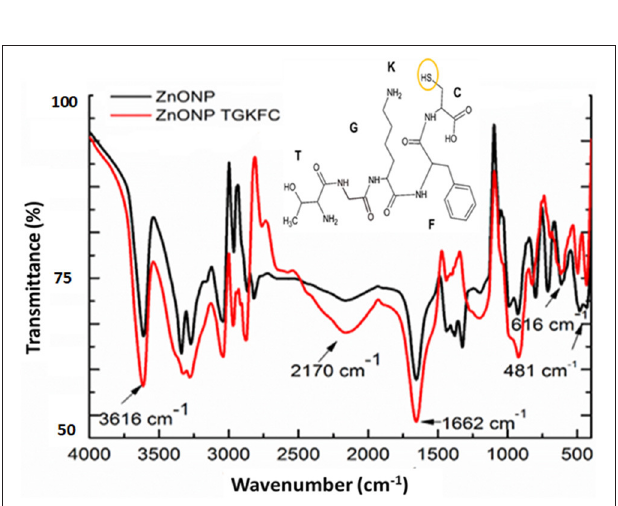
FIGURE 2 | Fourier transform infrared spectra of ZnONPs-TGKFC. Black line ZnONPs alone; Red line the ZnONPs bound to TGKFC. The molecular structure of the peptide was also reported highlighting the functional group involved in the stretching